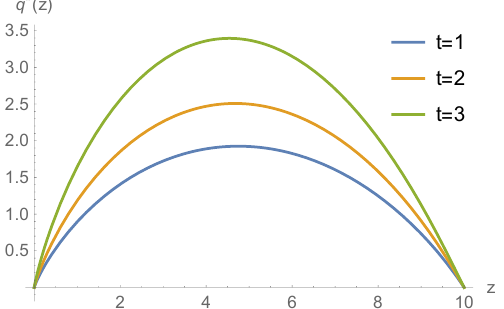
Figure 3. The optimal reinsurance policy with respect to z at time t = 1,2,3.